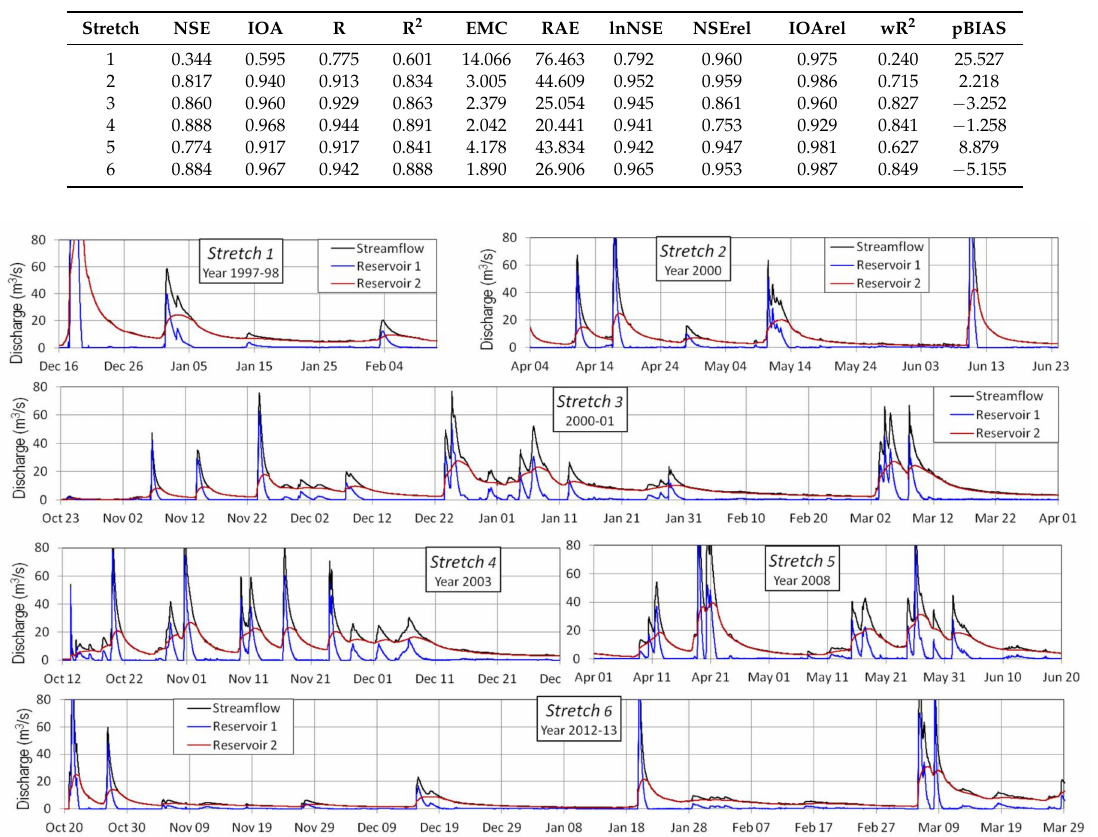
Table 4. Analysis using the efficiency criteria.